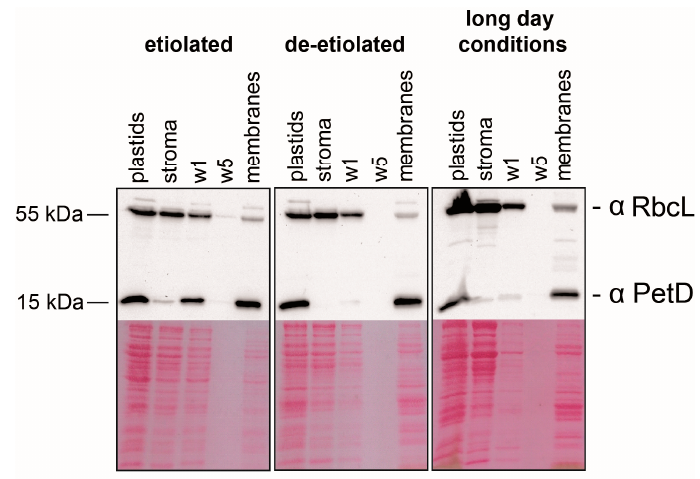
Figure 1. Enrichment of marker proteins in chloroplast membrane and stroma fractions. Western blot analysis was performed from each type of tissue using RbcL and PetD antisera as markers for stroma and membrane, respectively. RNAs from these fractions were used for microarray analysis. A seven hundredth of each sample was analyzed by sodium dodecyl sulfate polyacrylamide gel electrophoresis (SDS-PAGE). The membrane fraction was washed five times prior to RNA extraction. Aliquots from the supernatants of the first and the last wash were analyzed here as well (W1 and W5).